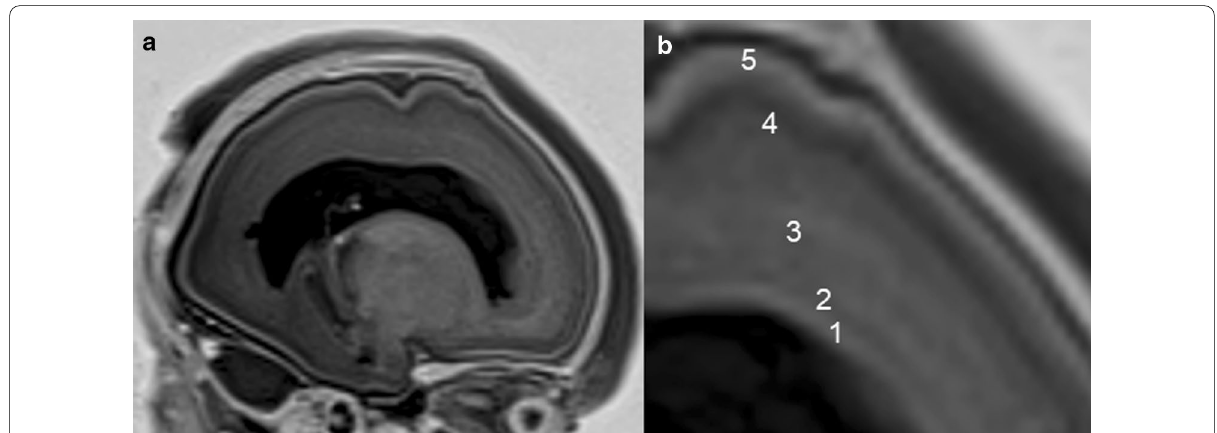
Fig. 1 23‑week foetus with normal cerebral lamination. a , b Sagittal T1‑weighted images show five laminar compartments: (1) ventricular zone; (2) periventricular zone; (3) intermediate zone; (4) subplate zone; (5) cortical